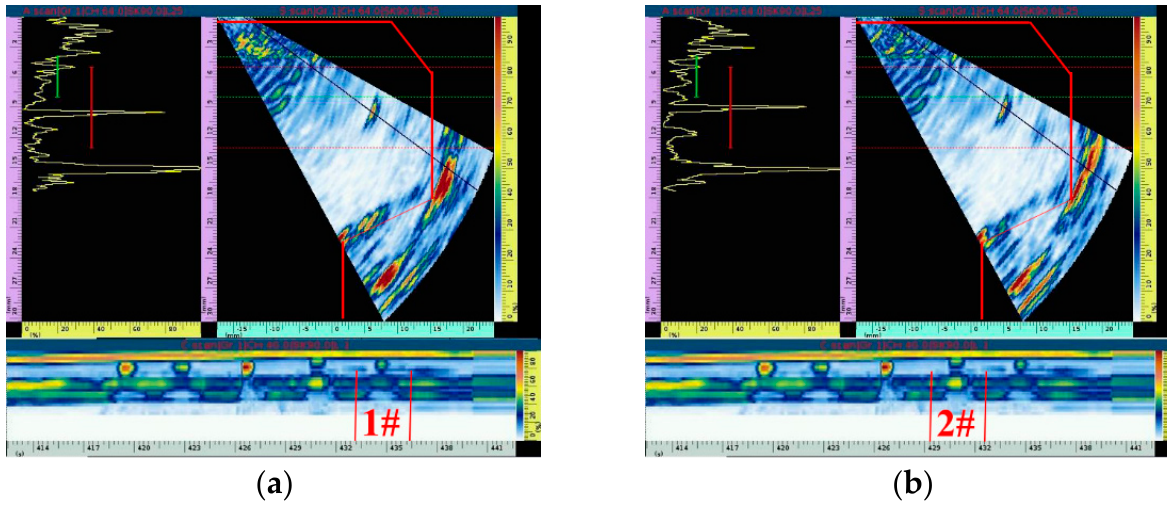
Figure 15. Signal echo analysis of two kinds of crack defects. ( a ) Defect 1#. ( b ) Defect 2#. The detection results of the simulated slag inclusion and porosity defects are shown in Figure 16a,b, respectively. As seen in the fan scan image, compared with the detection results of crack defects, the signal echoes of slag inclusion and porosity defects are stronger, resulting in fewer redundant signal echoes in the detection image, and it is easier to distinguish the structural signal echoes from the defect signal echoes. Similarly, the horizontal distance and vertical depth of slag inclusion and porosity defects are 10.2 mm and 7.8 mm, respectively, which are consistent with the actual position of defects inside the workpiece. The C-scanning image shows that the signal echo of the slag inclusion de- fect with the largest size is the strongest, followed by the porosity defect, which is also